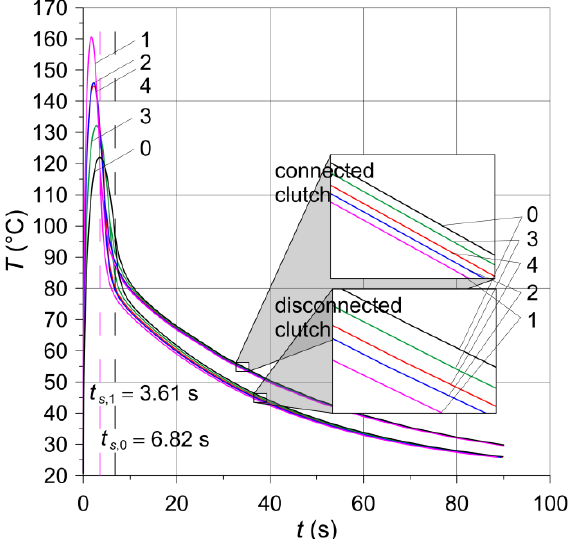
Figure 7. Evolutions of the temperature of the friction surfaces of the clutch on the equivalent radius r eq = 39.4 mm obtained by means of the computational model: from the article [6]—connected clutch; developed in this paper—disconnected clutch. Numbers 0–4 denote friction materials given in Table 1. Table 4. Calculated parameters for the cooling stage for five friction materials. Variant,